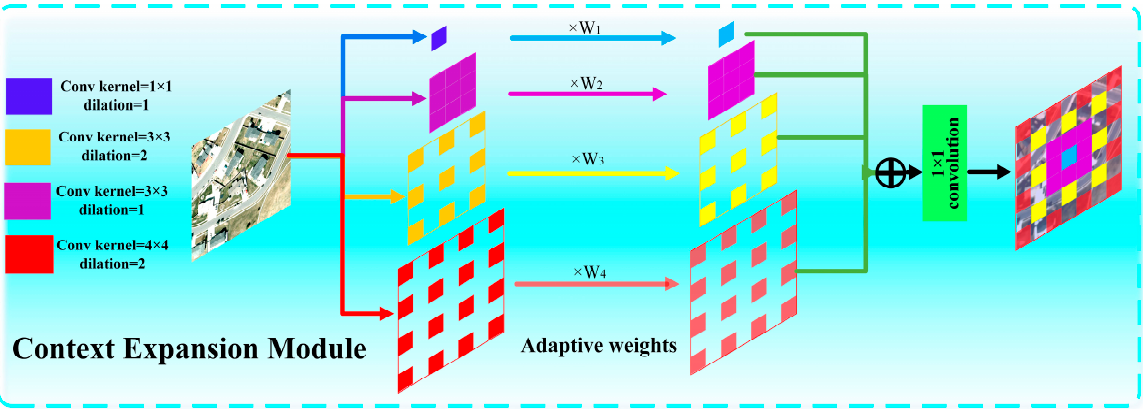
Figure 4. Context expansion module. Context expansion module contains four convolutions with different dilation rates and kernel sizes to expand the receptive field, i.e., kernel size 1 × 1, kernel size 3 × 3 with dilation rate 1, kernel size 3 × 3 with dilation 2 and kernel size 4 × 4 with dilation rate 2.